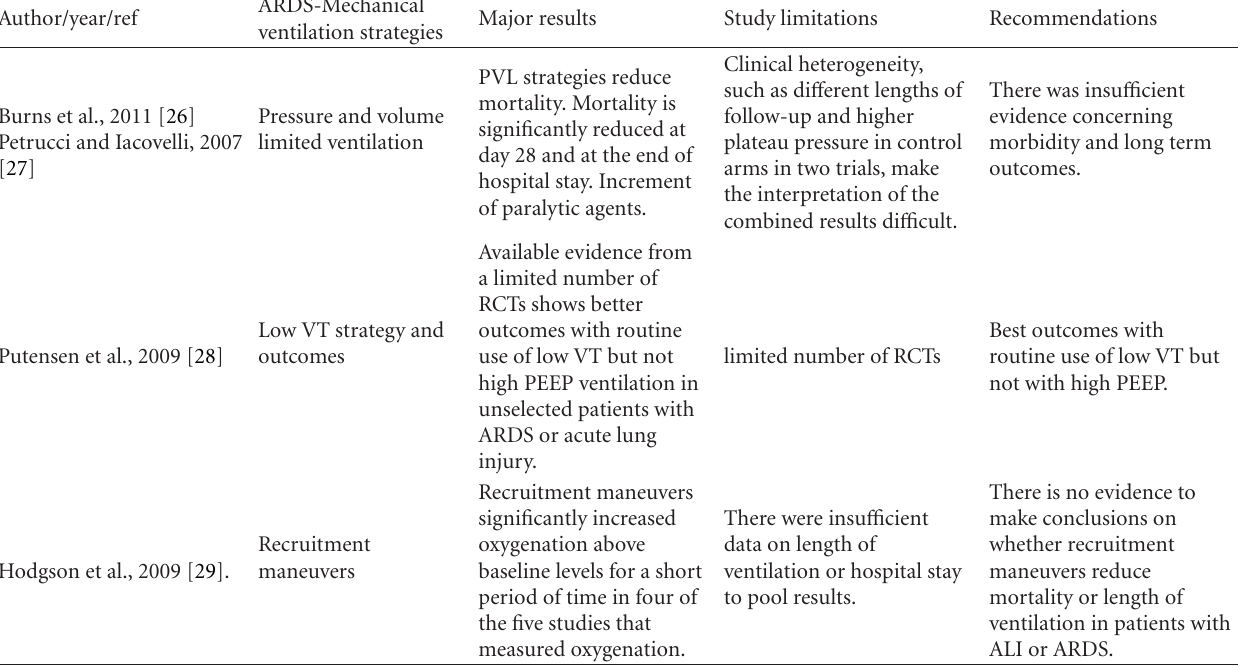
Table 2: Meta-analysis studies of ARDS ventilation and strategies (last year 10 year-humans) years